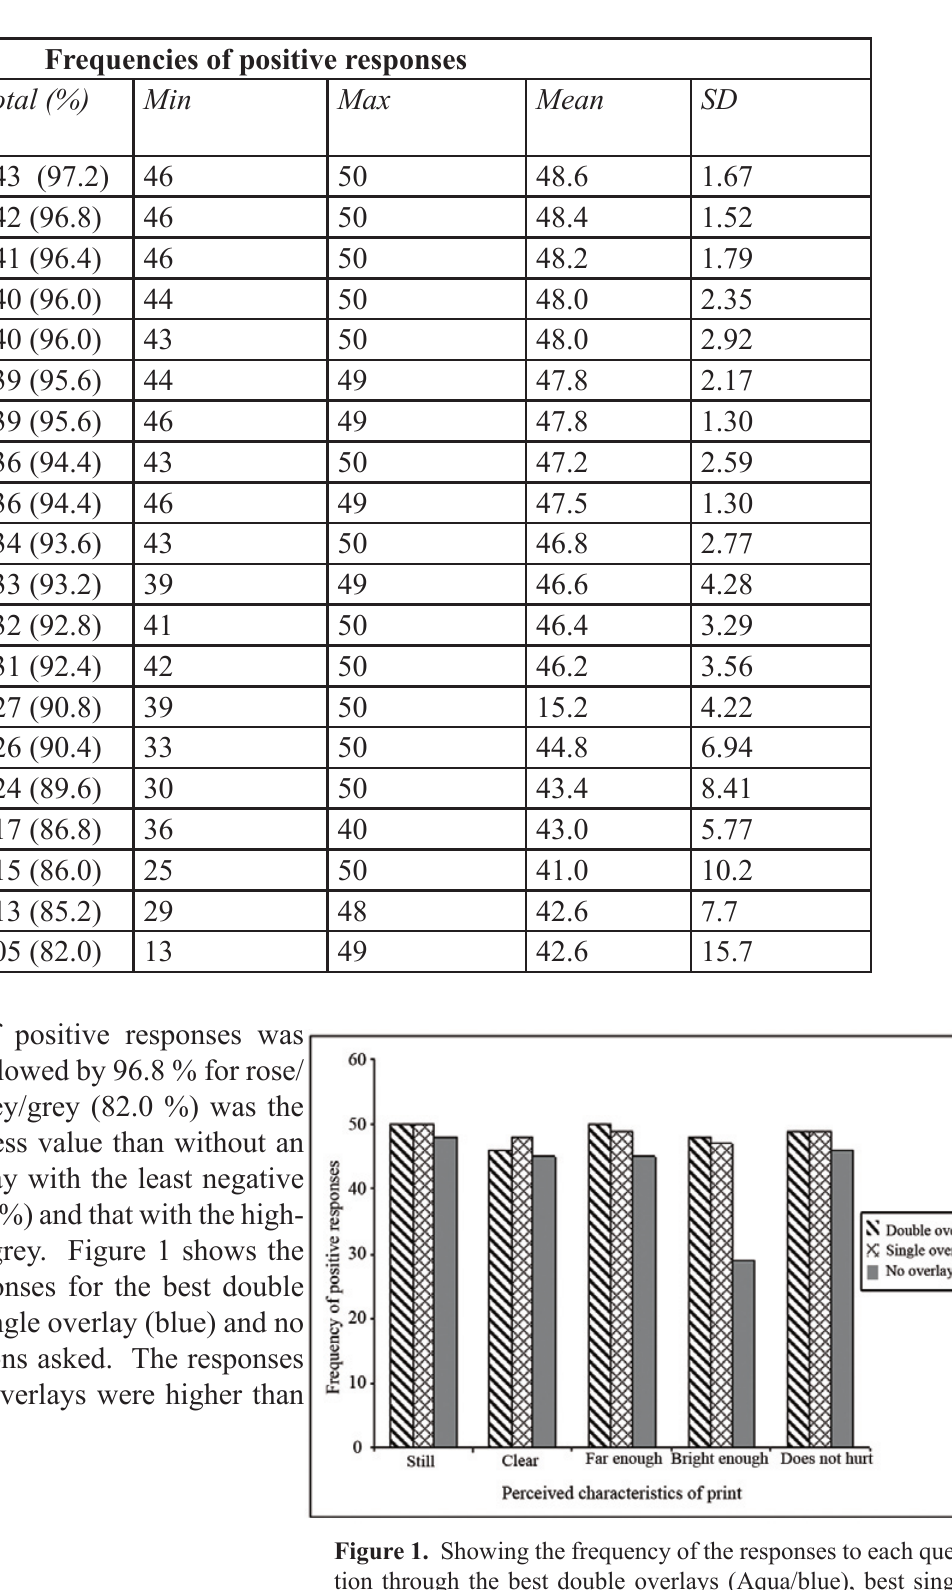
Table 4. The total and percentage, minimum, maximum, mean and standard deviation of the positive responses by the 50 subjects